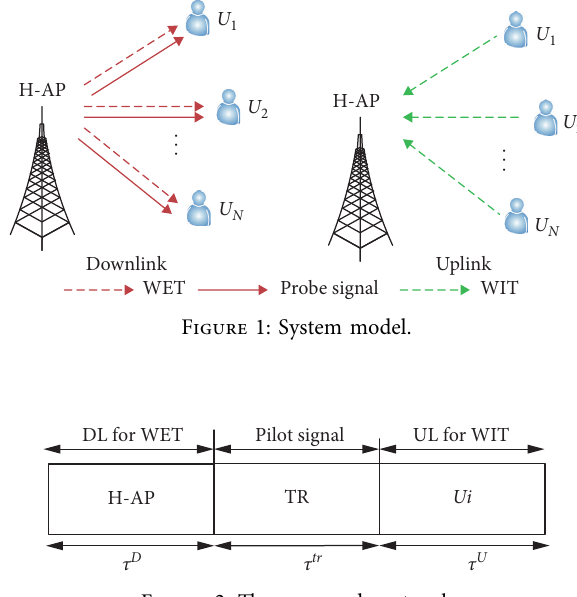
Figure 2: The proposed